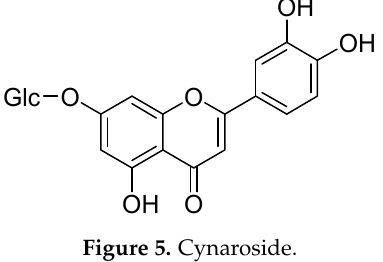
Figure 5. Cynaroside.